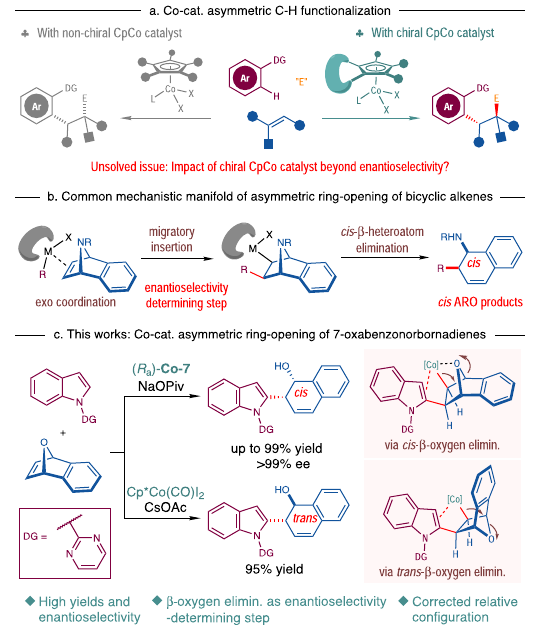
Fig. 1 | Asymmetric ring-opening of bicyclic ole fi ns via Co-catalyzed C – H functionalization. a Co catalyzed asymmetric C – H functionalization. b